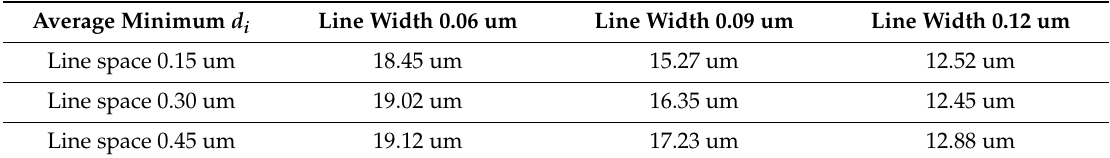
Table 1. The average minimum d i , which keeps the rate of change of the dishing defect D i within 5%. Average Minimum d